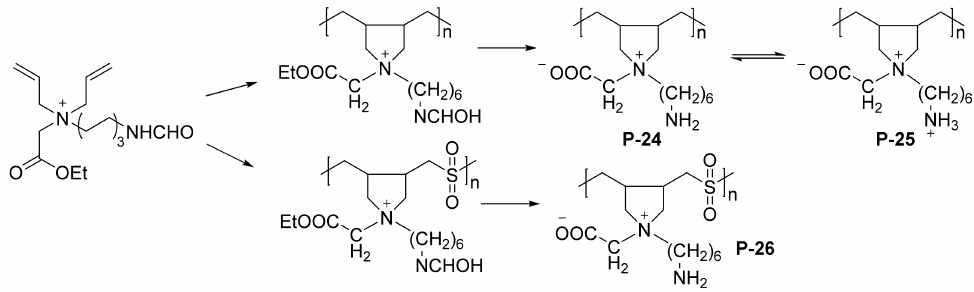
Figure 8. Typical synthetic route of polyquaternary ammonium type inhibitors via Butler’s cyclopoly-